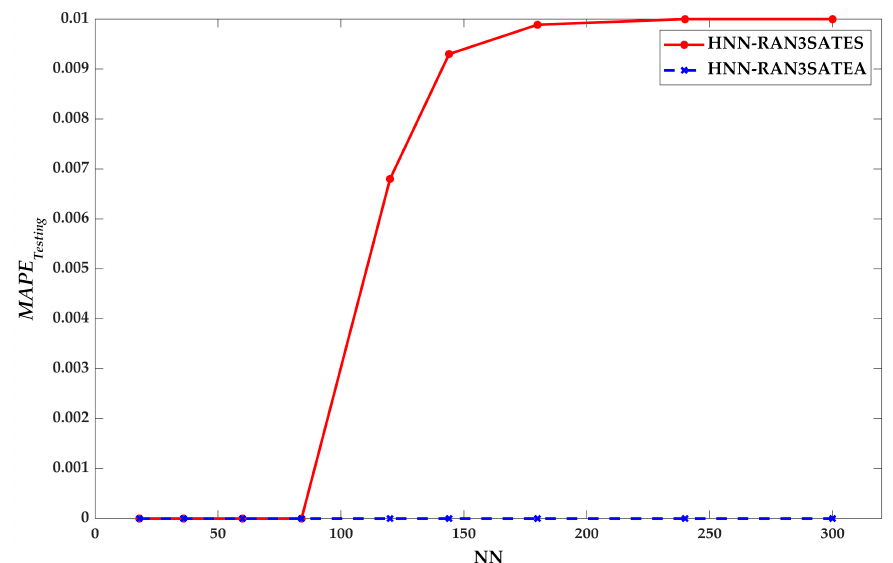
Figure 8. MAPE Testing for HNN-RAN3SAT Figure 8. Testing MAPE for HNN-RAN3SAT model. Figure 8. Testing MAPE for HNN-RAN3SAT model.